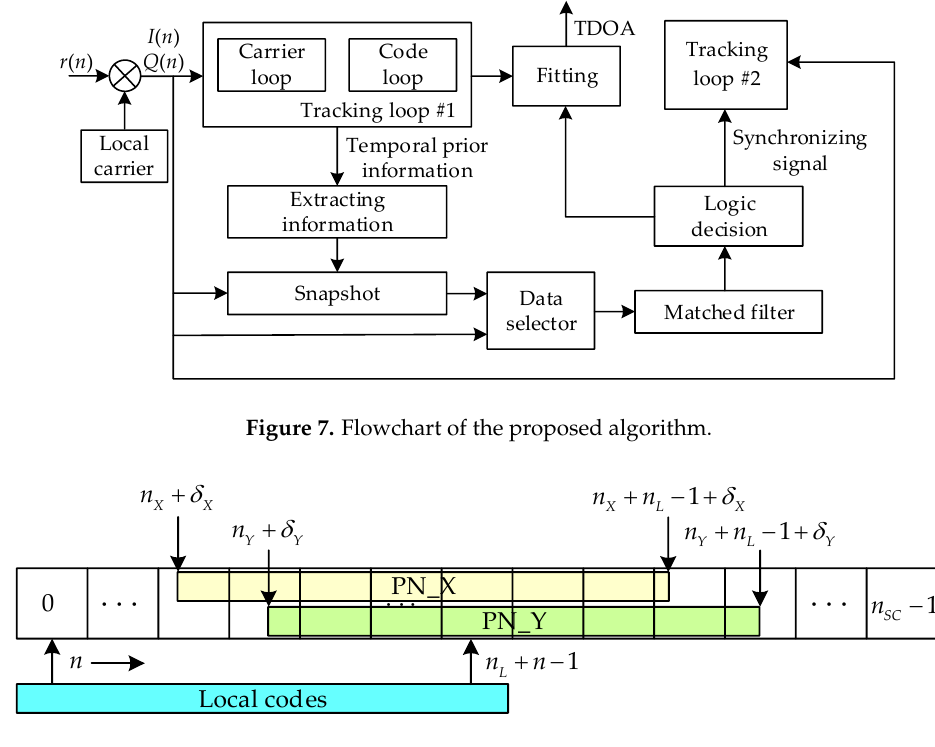
Figure 8. Flowchart of the proposed algorithm.